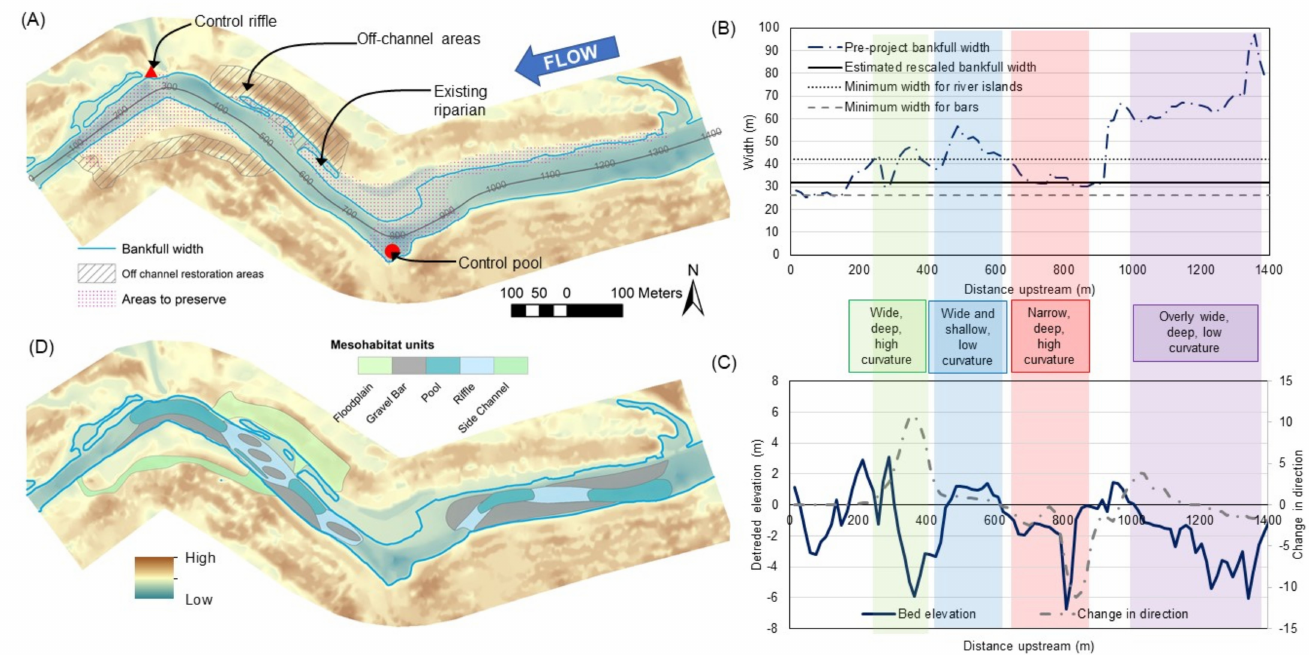
Figure 8. Example of a mesohabitat unit design for a reach of the Merced River below Crocker- Huffman Dam in California, USA. Pre and post-project conditions are shown in Figure 1 and the project basis can be found in [39]. First ( A ), the existing geomorphic controls and available corridor space are determined. In this case, existing riparian vegetation and two control units bounded the potential area to be rescaled. The current bankfull width in relation to thresholds for the rescaled bankfull channel and river bars can help identify areas of mesohabitat units ( B ). Equation (3) was used to predict the rescaled bankfull width and Equation (4) was used to predict the minimum width for islands and point bars. In this example it is apparent that the channel is overly wide compared to the current bankfull flow, supporting the idea to infill and nest a rescaled alluvial river